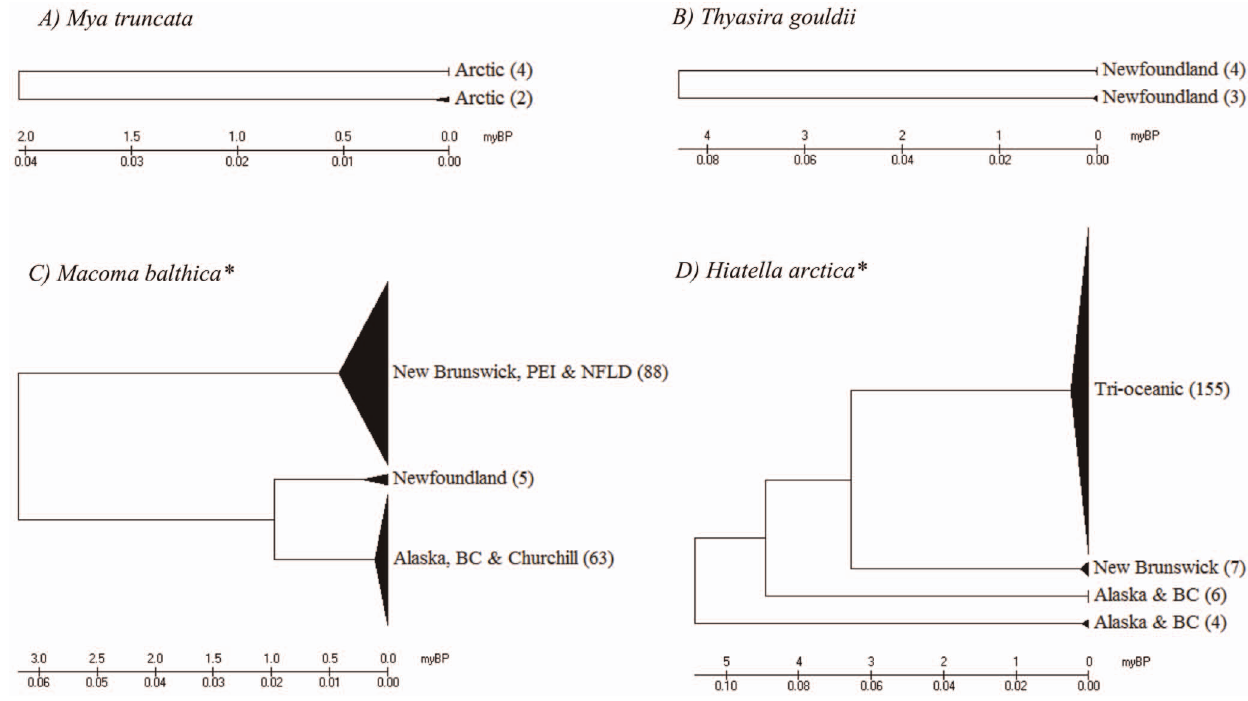
Figure 7. Deep divergences at COI within species of bivalve. Neighbour-joining trees (K2P) with locality information for four bivalve species showing more than 2% sequence divergence at COI. Triangles on the NJ tree represent compressed clades, with sample size provided in brackets. *(Layton 2012)